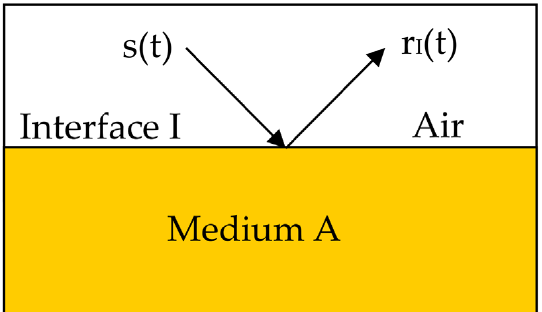
Figure 4. Electromagnetic Wave Reflection Behavior in Medium.